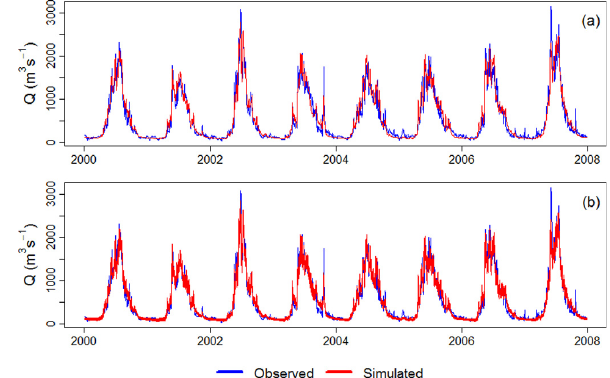
Fig. 4. Observed and simulated discharge for the test period (2000– 2007). (a) observed and simulated discharge predicted with the best performing ( E ) parameter set; (b) observed and the ensemble of simulated